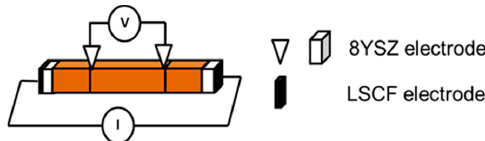
Figure 11. Schematic diagram of the four-probe DC method used for ionic conductivity measurement.